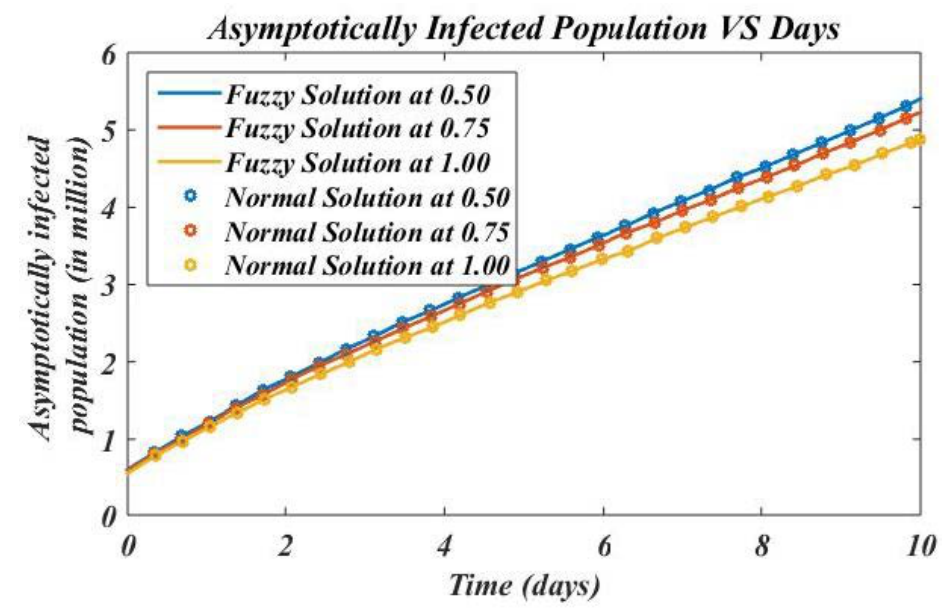
Figure 5. Illustration of approximate fuzzy and normal asymptotically infected compartment solu- tions for three terms at given uncertainty levels ϑ ∈ [ 1,2 ] versus fractional order.